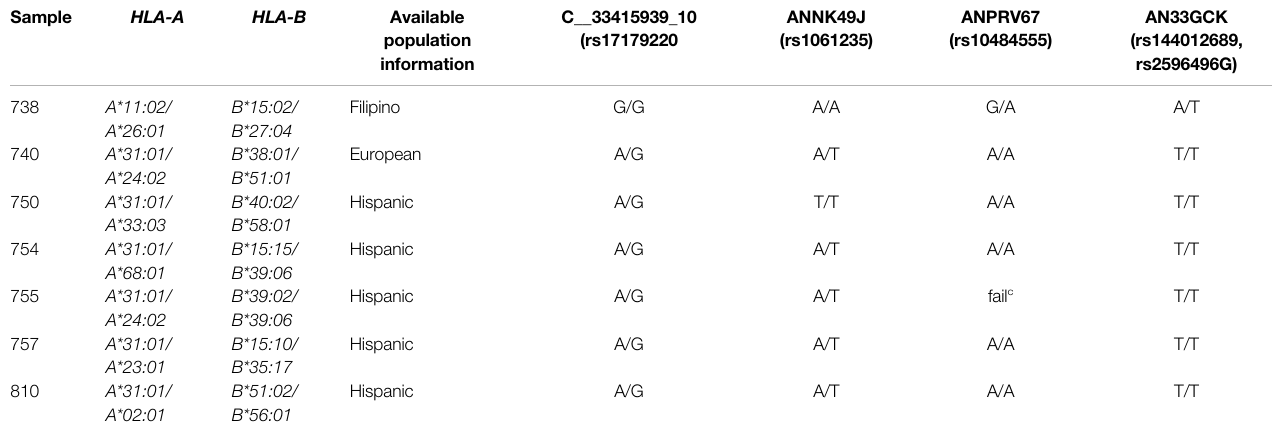
Frontiers in Pharmacology |